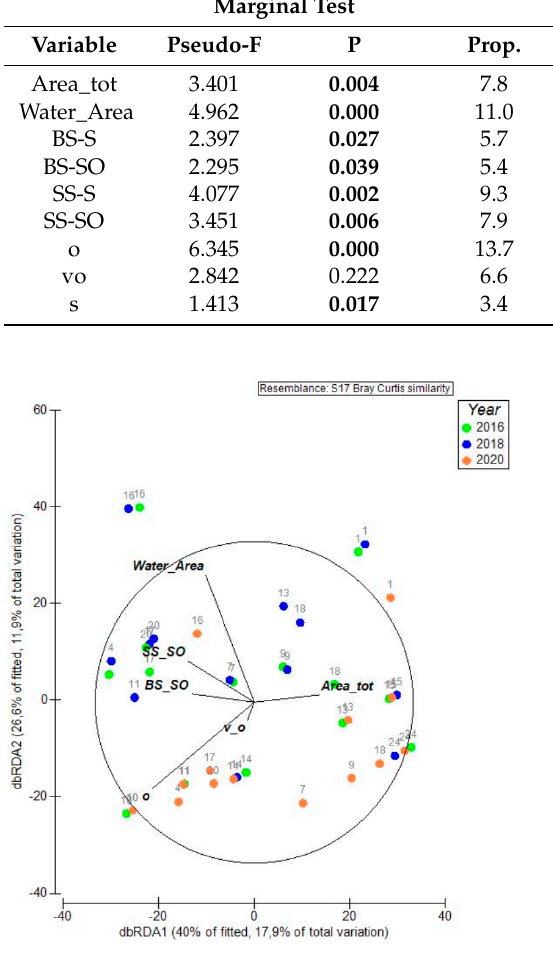
Figure 5. Distance-based redundancy analysis (dbRDA) ordination representing differences in dominant plant communities among kettle holes over the three years. Abbreviation of environmental variables see Table